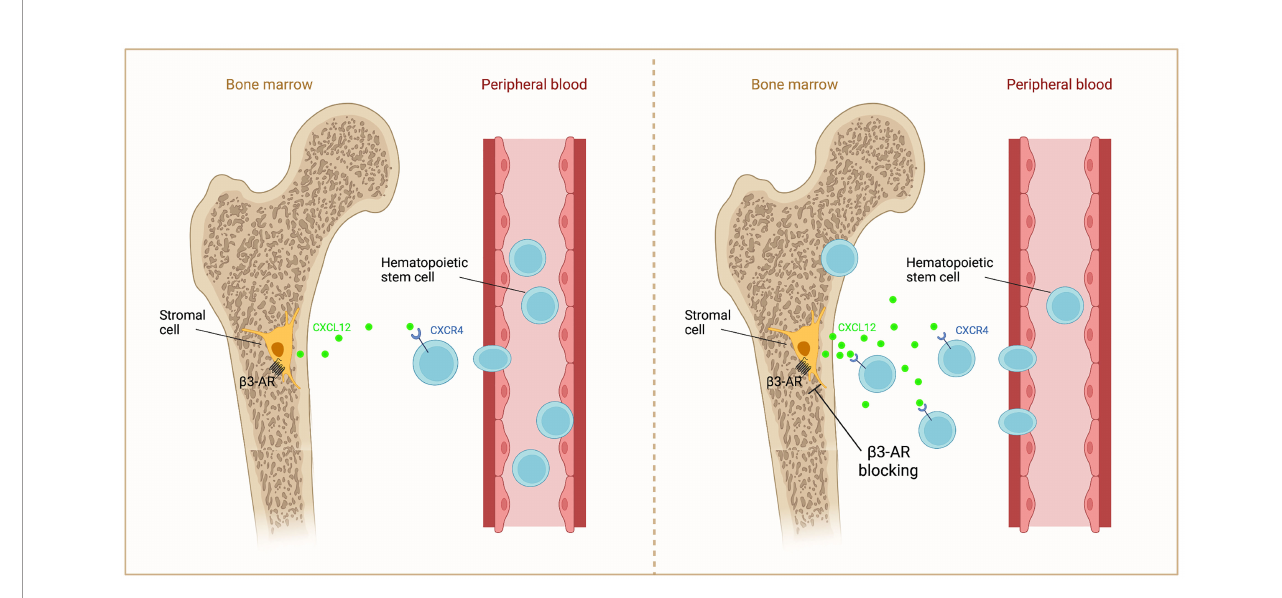
FIGURE 2 | Schematic representation of b 3-AR action on Cxcl12 in BM. b 3-AR signaling decreases Cxcl12 secretion by stromal cells (left). b 3-AR blocking increases Cxcl12 release, inducing the homing of HSCs to the BM